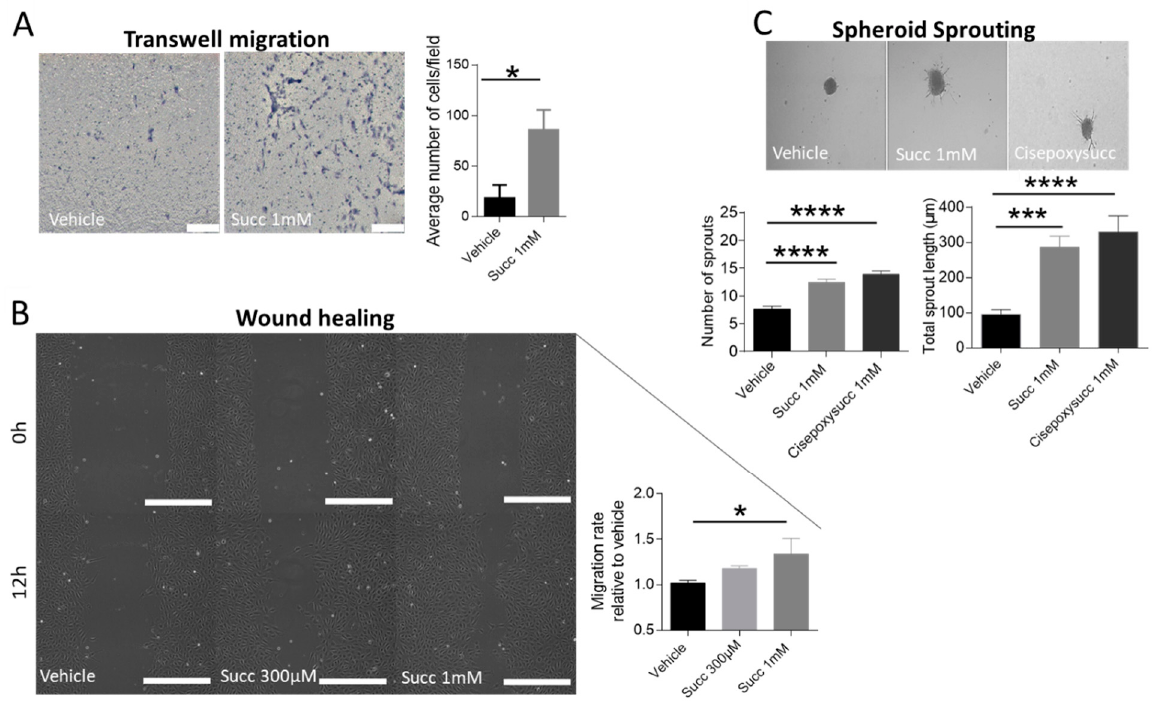
Figure 5. Succinate induces the chemotactic mobility, wound healing and sprouting of HUVECs. ( A ) Transwell migration assay of HUVECs in response to vehicle or succinate (scale bar 200 µ m, objective 10x). Migrated cells were counted after 16 h on the lower surface of the filter and average numbers per field were calculated; paired t -test, * p < 0.05 ( n = 4). ( B ) Scratch assay of HUVECs monolayer treated with vehicle or succinate. Distance migrated by cells over time was calculated and analyzed after 12 h. One-way ANOVA followed by Dunnett’s post hoc test was used, * p < 0.05 ( n = 3, scale bar 500 µ m, objective 10 × ). ( C ) Spheroid sprouting assay of HUVECs in response to succinate or cis -epoxysuccinic acid relative to vehicle indicated by total sprout length and number of sprouts. One-way ANOVA followed by Dunnett’s post hoc test was used, *** p < 0.001, **** p < 0.0001 ( n = 5). For A, B and C, representative images are included and data are shown as mean ± SEM.